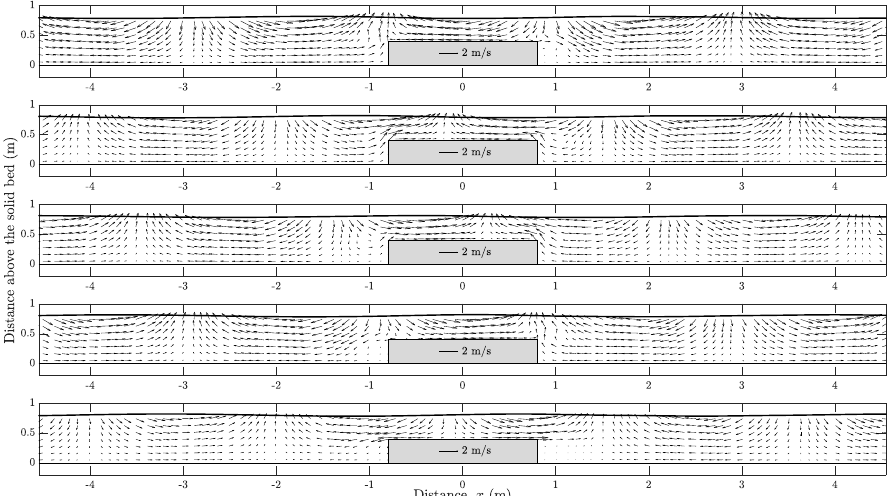
Figure 15. Snapshots of velocity field due to a bottom obstacle on a solid bed ( d m = 0 ) at six time instants over a wave period. Top to bottom: t / T = 1 surface. See Figure 13 for the model inputs.